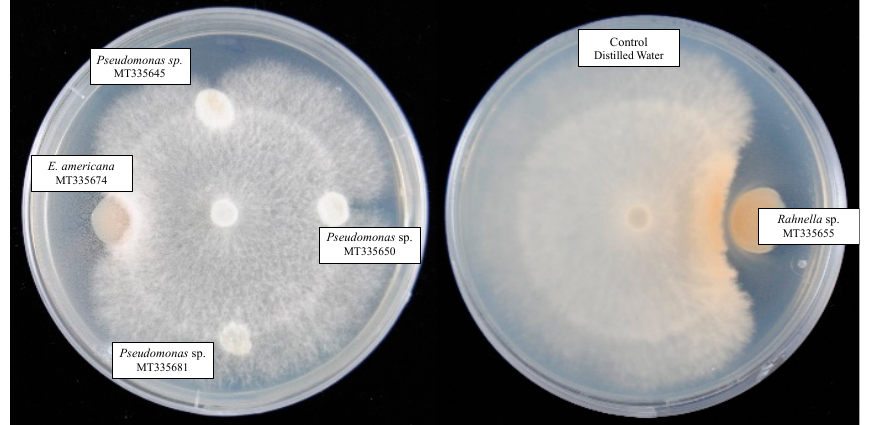
Figure 4. Inhibition of L. edodes mycelium (in the center of the plate) by the isolated strains, and negative control (sterile distilled water). Strains were incubated for two weeks at 10 °C.